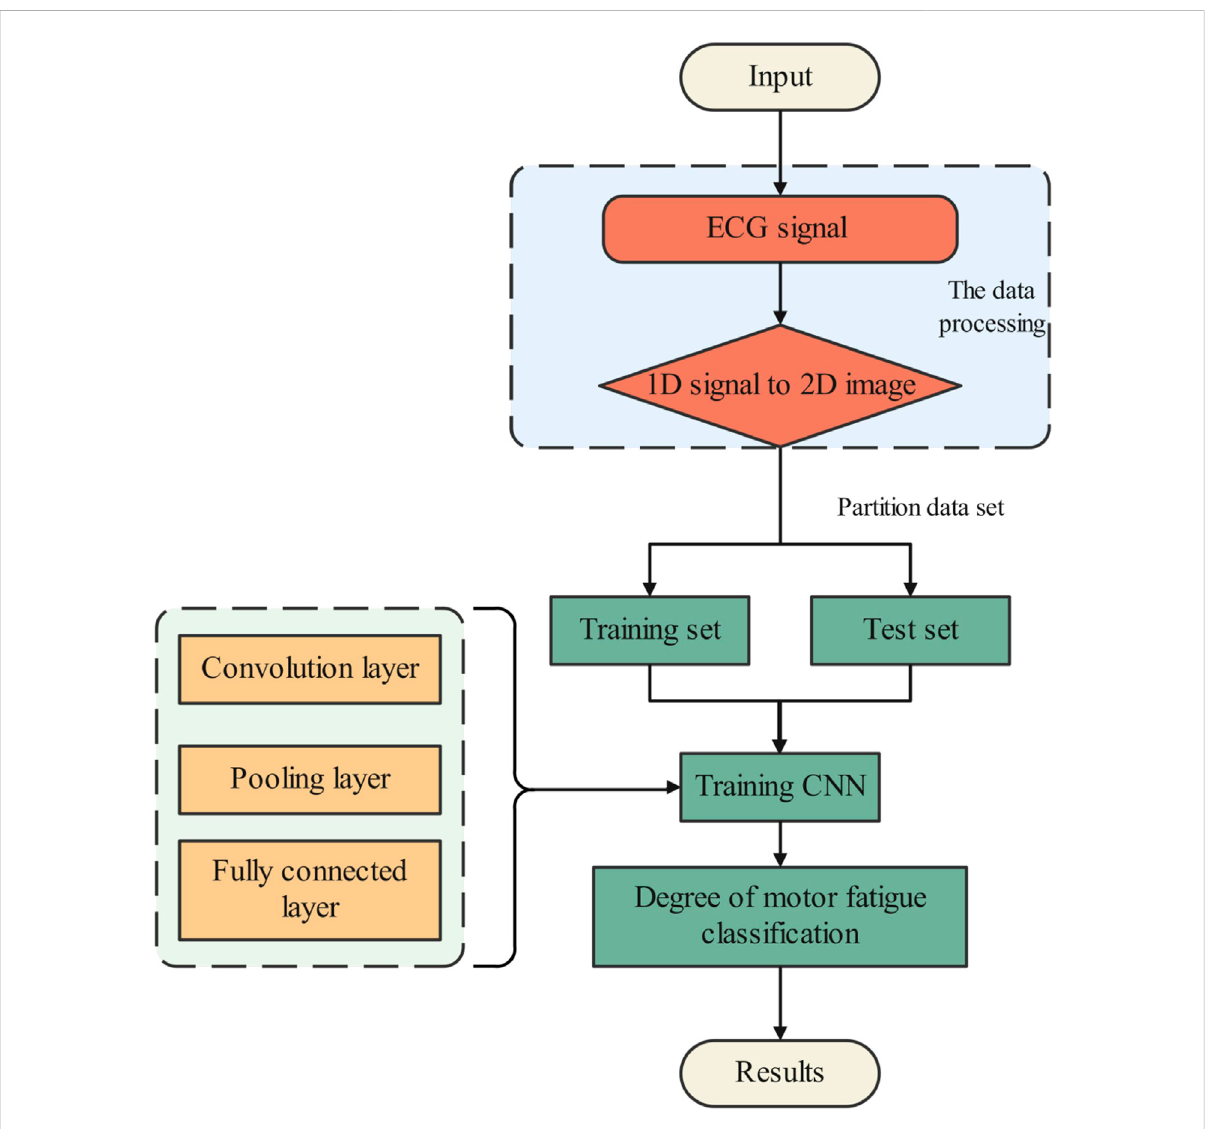
FIGURE 4 Overall fl ow